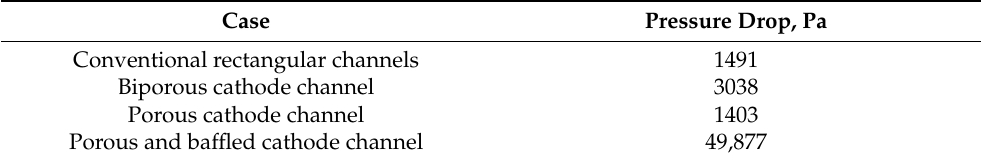
Table 6. Porosity and permeability of channel and biporous layer.